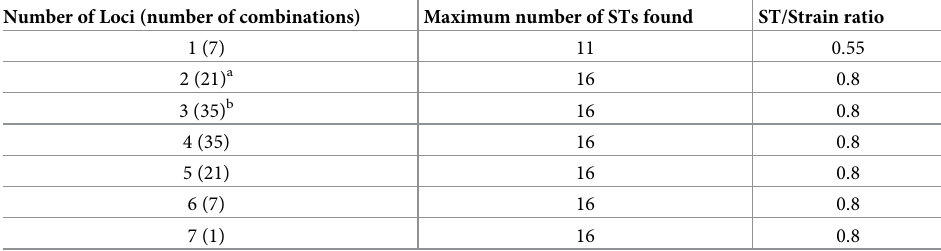
Table 3. Optimum number of loci combination based on MLSTest. Number of Loci (number of